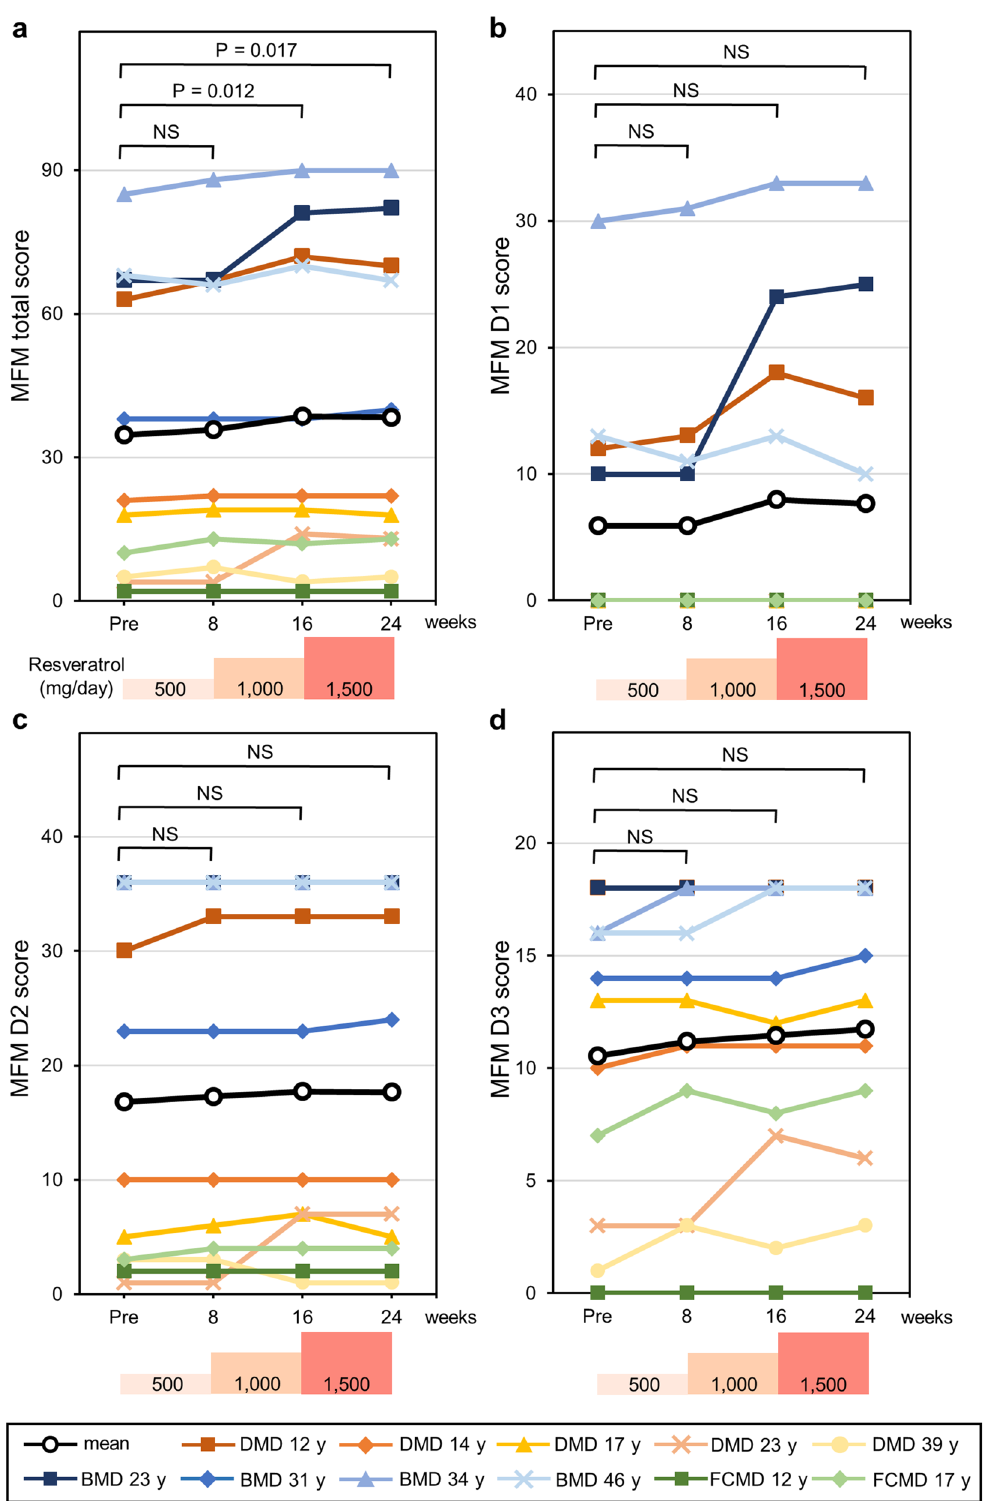
Figure 2. Motor function scores following resveratrol administration. ( a ) Total score, ( b ) D1 sub-score in standing position and transfers, ( c ) D2 sub-score in axial and proximal motor function, and ( d ) D3 sub-score in distal motor function of each patient are measured with the MFM scale before (Pre) and at 8, 16, and 24 weeks. Black lines show mean values. Average values at each visit were compared with those before medication and were analysed using ANOVA. Post hoc analysis was performed using Dunnett’s test. P values < 0.05 are indicated. NS: not